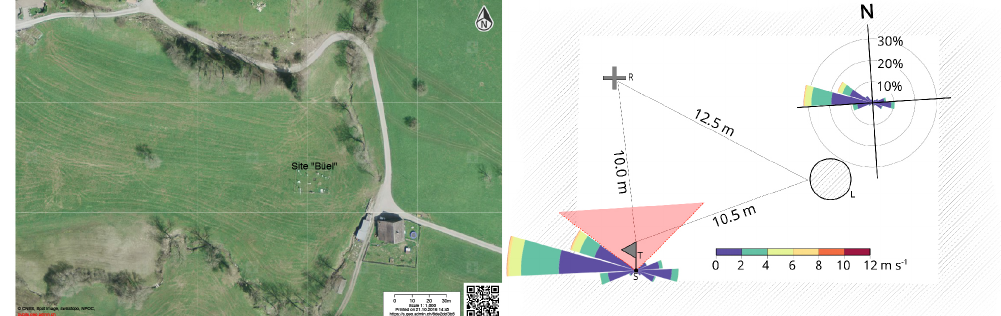
Figure 2. Left panel: aerial map of the site (see https://s.geo.admin.ch/6de2dcf3b5 for an interactive online version of the map) and right panel: schematics of the EC tower (denoted T), lysimeter (L), and radiation (R) measurement setup as well as the frequency of wind direction and velocity at the site “Büel” (white rectangle defines the area of the measurement field). The distance between the tower and the sonic (S) volume equals 1.17m. The wind sector obstructed by the tower and the IRGA is highlighted in red and masked for the analyses (from 310 to 50 ◦ ). The identical hatching of the surrounding grassland and the lysimeter surface indicates that the latter is treated according to the former (see text for